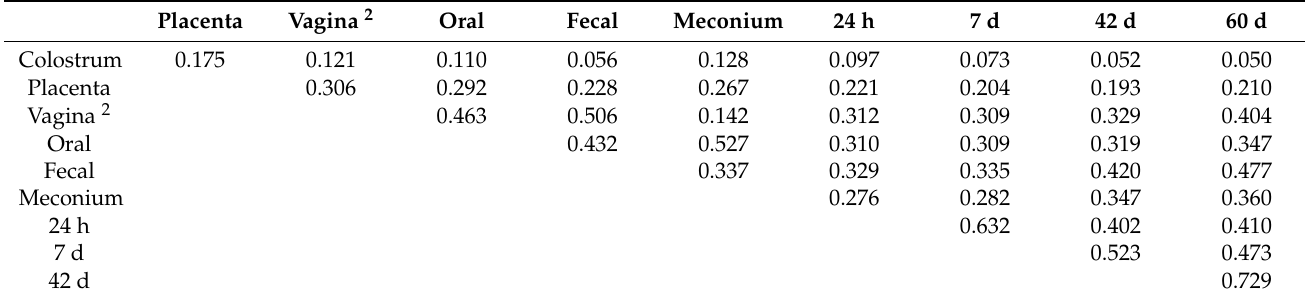
Table 3. Spearman rank correlation r s between genus relative abundance of the maternal microbiomes at calving and its calf’s fecal microbiome from calving until 60 d of age 1 .